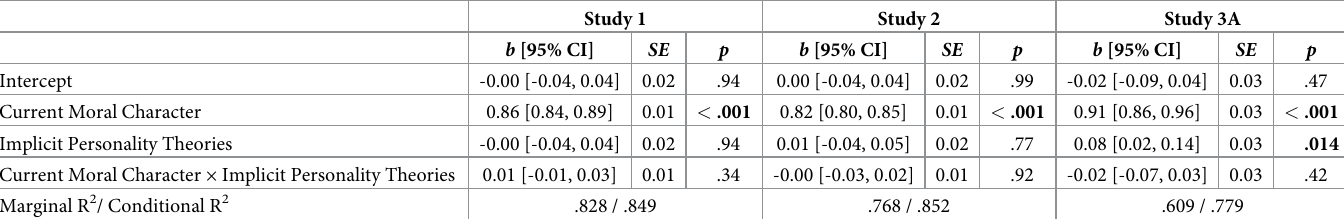
Table 2. Forecasts about future moral character predicted by (a) inferences about current moral character, (b) individual differences in implicit personality theo- ries, and (c) the interaction between current moral character and implicit personality theories.